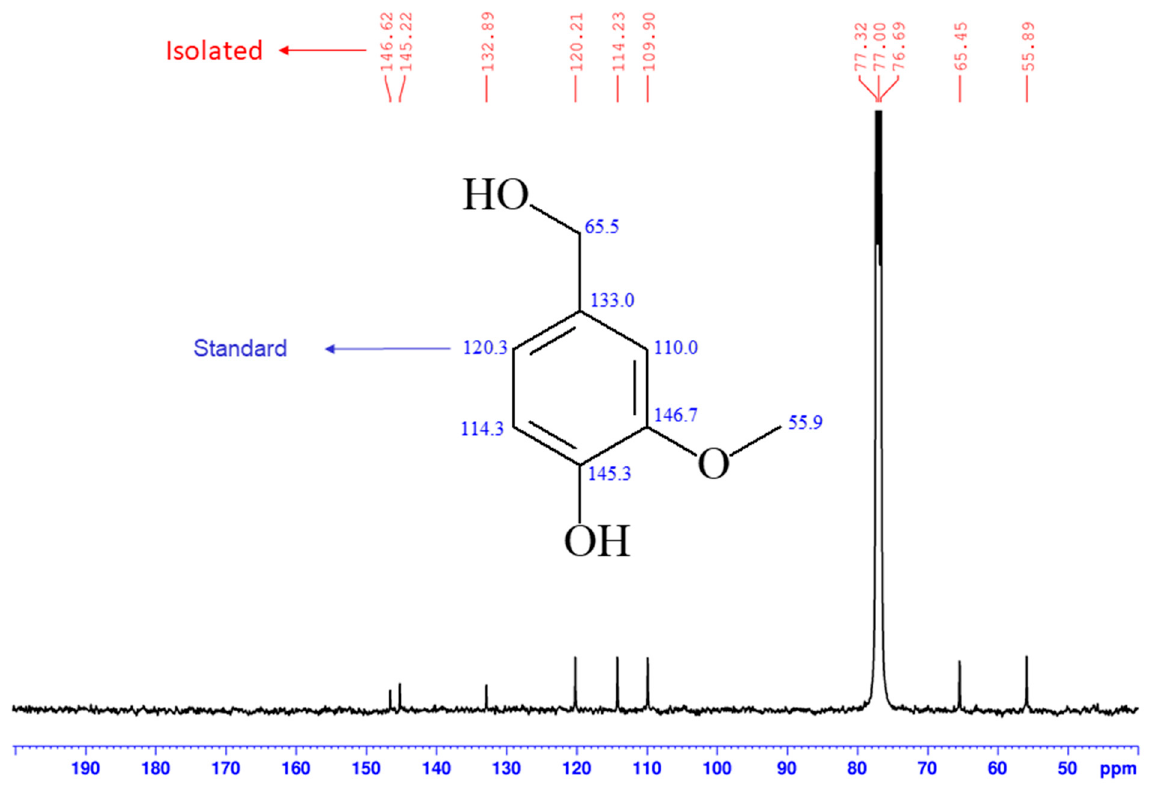
Figure 4. The 13 C NMR data of the standard (blue) vs. our isolated (red) samples of 2 .